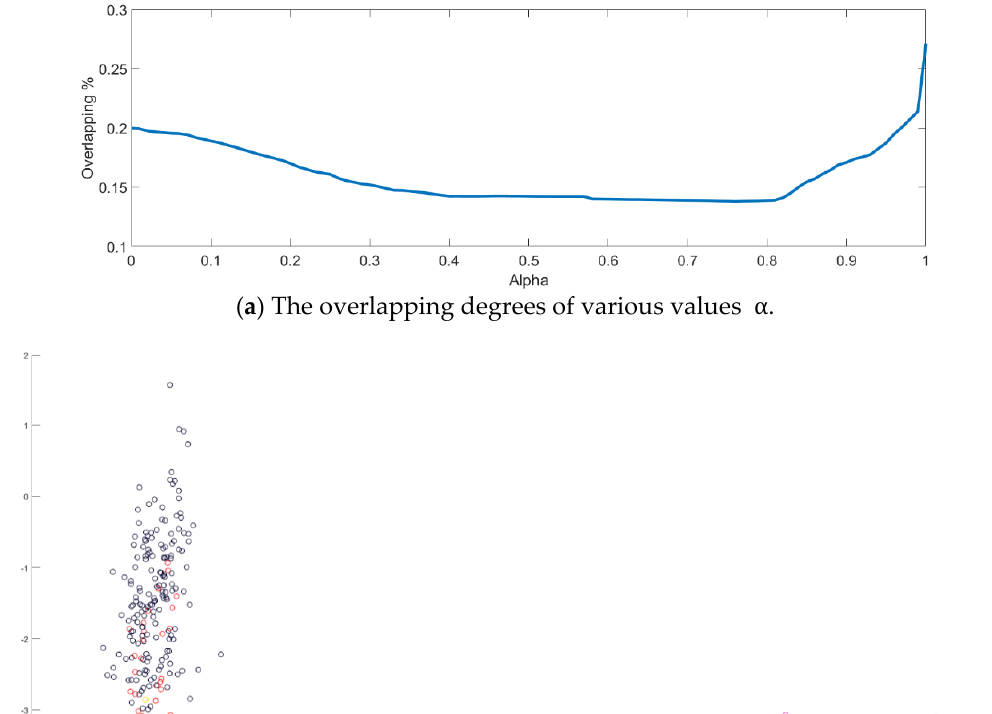
( b ) The visualized training sample distribution of PCA, 𝑟 = 0.42 .